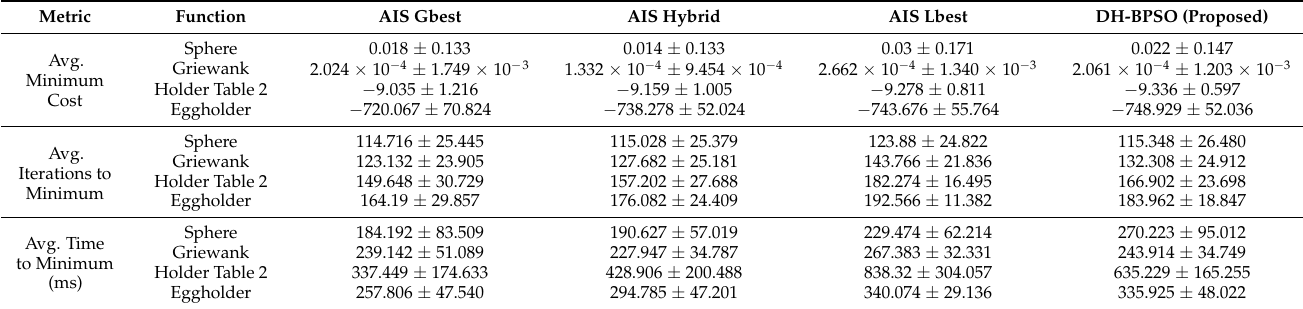
Table A1. Comparison of Artificial Immune System (AIS) BPSO algorithms solving 100-variable test functions using 10 particles and a maximum iteration of 200 averaged over 500 runs.